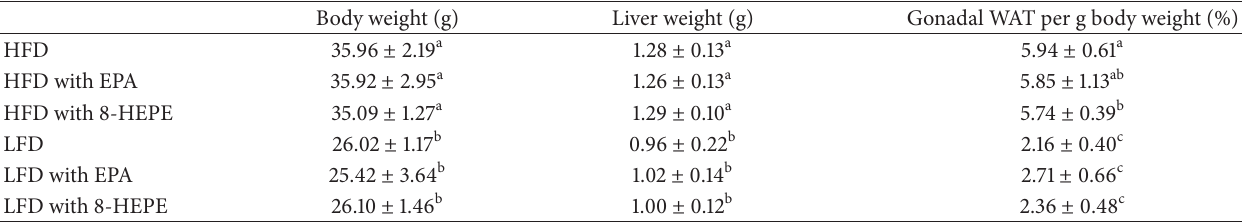
Table 1: Body weights, liver weights, the relative amount of gonadal WAT per g body weight in male C57BL/6J-DIO mice fed HFD, HFD with EPA, HFD with 8-HEPE, LFD, LFD with EPA, or LFD with 8-HEPE for 4 wk. Values are means ± SDs, 𝑛 = 9 . Labeled means without a common letter differ; 𝑃 < 0.05 . HFD: high-fat diet; LFD: low-fat diet; HEPE: hydroxyeicosapentaenoic acid; EPA: eicosapentaenoic